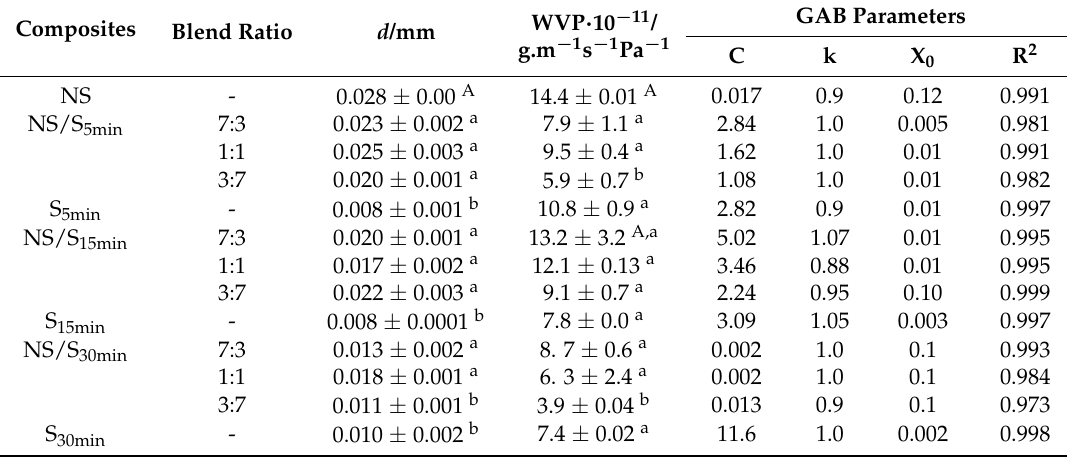
Table 1. Film thickness ( d ), water vapor permeability (WVP) and GAB parameters obtained from fitting of the data displayed in Figure 2 to Equation (2) for biobased films prepared from nonsonicated chitosan (NS), sonicated chitosan (S), and NS/S